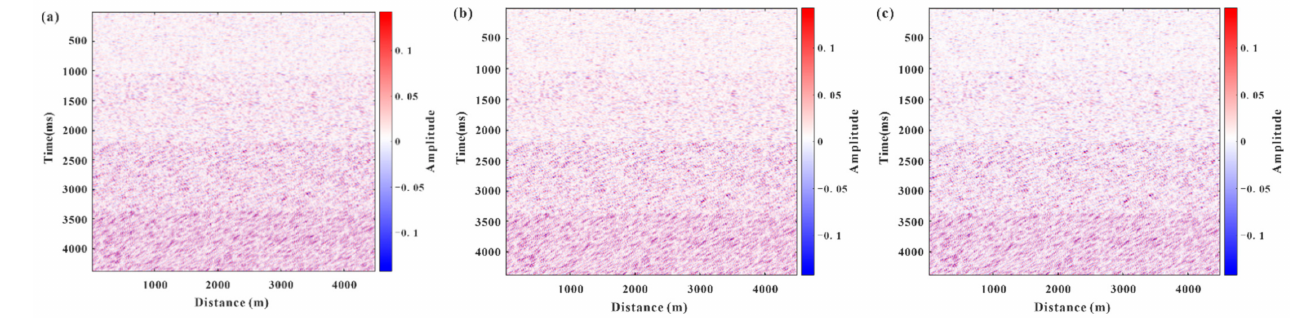
Figure 3. Petrophysical parameter model: ( a ) porosity, ( b ) clay volume, ( c ) water saturation.